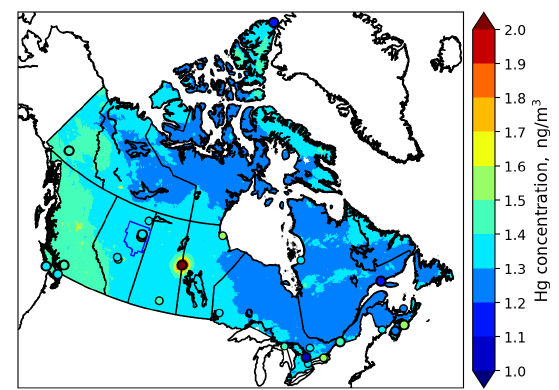
Figure 7. Model-simulated spatial distribution of annual average surface air GEM concentrations in Canada in 2013; colours in cir- cles show observed concentrations for 2013 (large circles) and pre- vious years (small